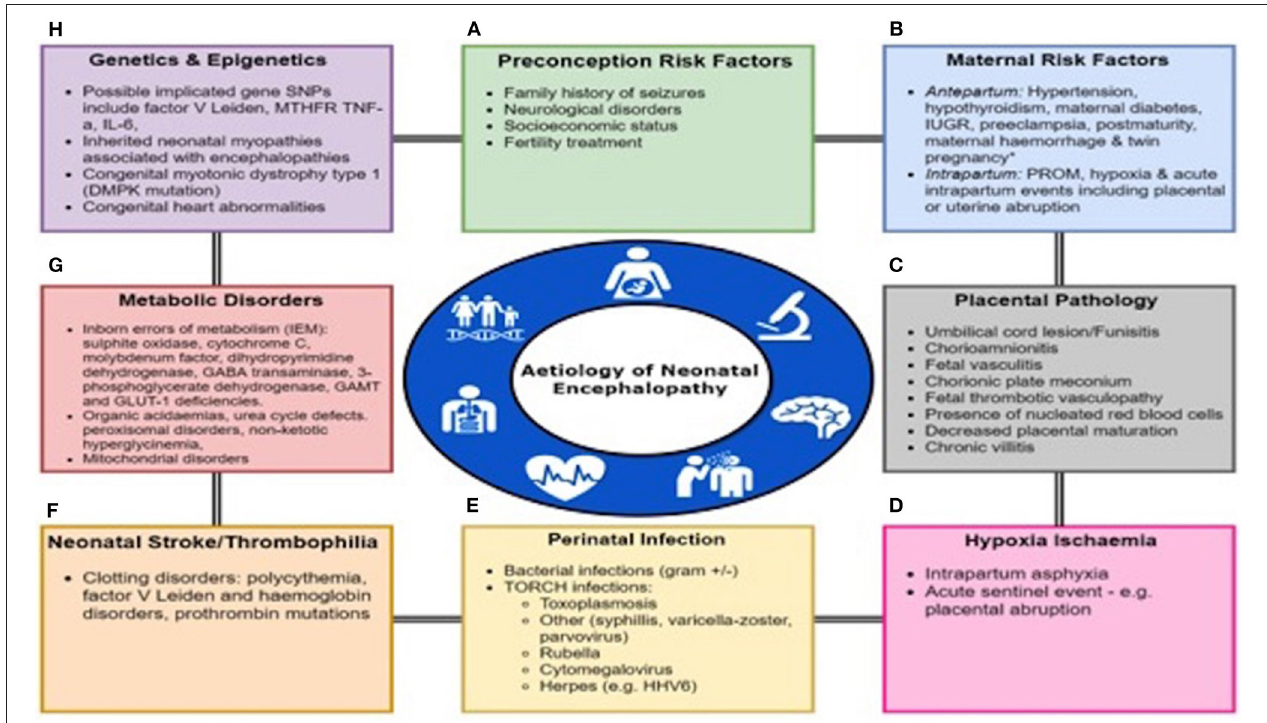
FIGURE 1 | Multifactorial Etiology In Neonatal Encephalopathy. Many factors predispose to the onset of Neonatal Encephalopathy either alone or in a combination including (A) Preconception Risk Factors, (B) Maternal Antepartum/intrapartum comorbidities or events, (C) Placental pathology, (D) Hypoxia-ischaemia, (E) Perinatal infection, (F) Neonatal stroke or thrombophilia, (G) Metabolic disorders, and (H) Genetic and epigenetic abnormalities. PROM, prolonged rupture of membranes; IUGR, intrauterine growth